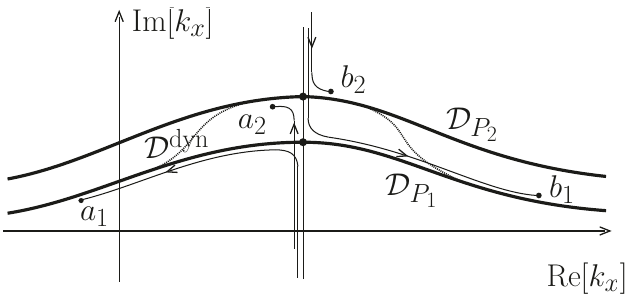
Figure 10 . Multiple thresholds with the same external momentum p .